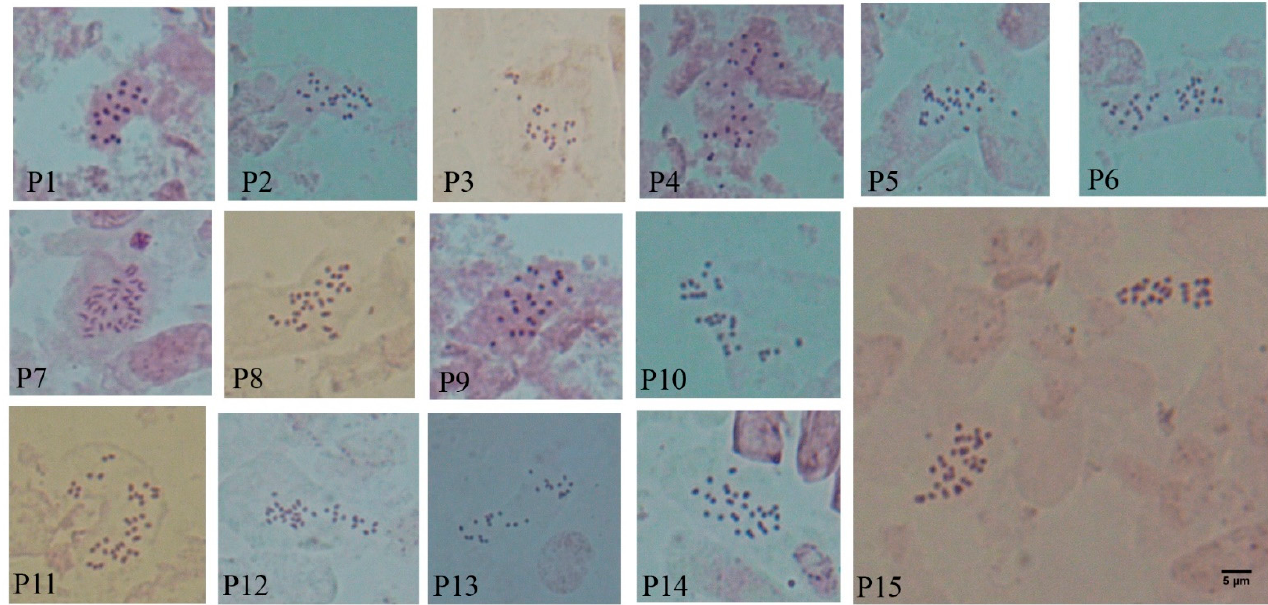
Figure 1. Somatic chromosomes of 15 Hypericum perforatum L. populations. Scale bar = 5 μ m.